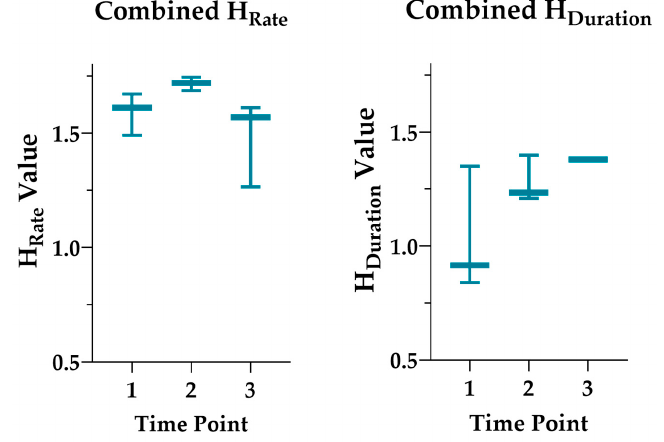
Figure 5. Box plots of diversity index H Rate ( left ) and H Duration ( right ) for all species over three time points: (1) Before environmental change, (2) 10–21 days post-change, (3) 230–250 days post-change. Graphs present median, minimum, and maximum value.